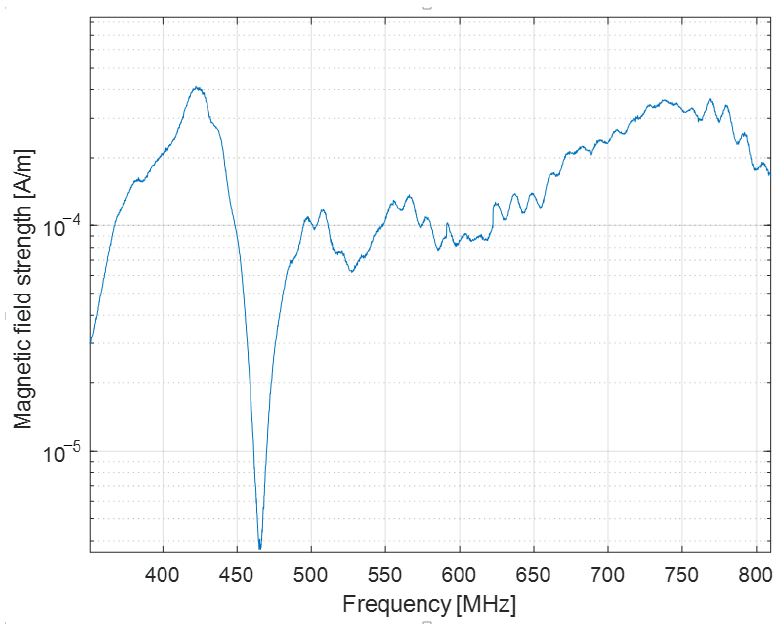
Figure 32. Magnetic field generated by common mode currents.